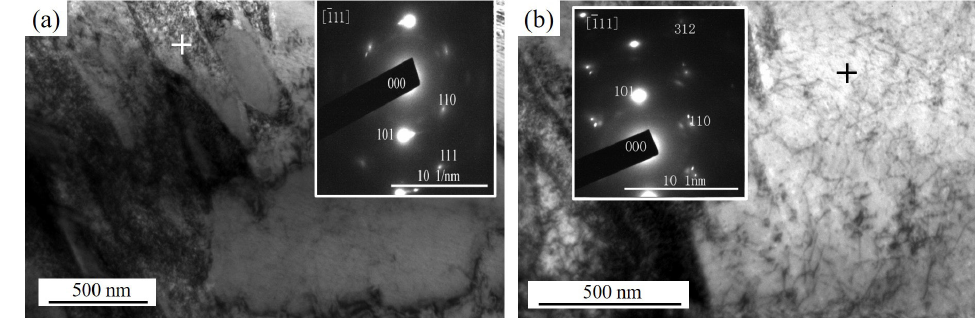
Figure 7. TEM and diffraction spots in the fusion zone.